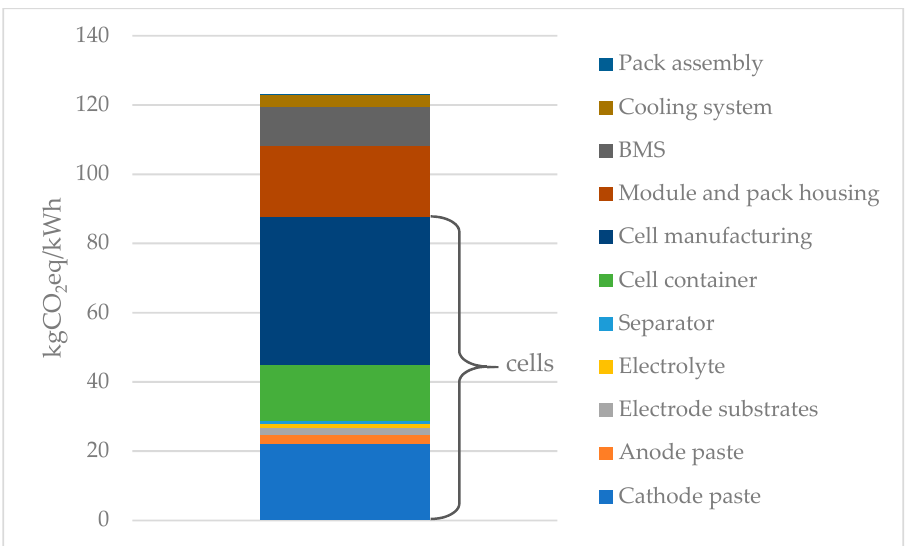
Figure 6. Cradle-to-gate greenhouse gas (GHG) emissions of a pack manufactured in Korea in an average capacity plant. BMS: battery management system.